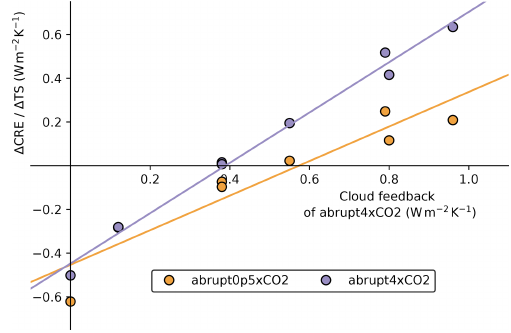
slopes for abrupt0p5 × CO 2 Figure 11. Comparison of the (cid:49) CRE (cid:49) TS and abrupt4 × CO 2 (shown in Fig. 10) with cloud feedback esti- mates computed from abrupt4 × CO 2 in CMIP6 models (values from Zelinka et al.,